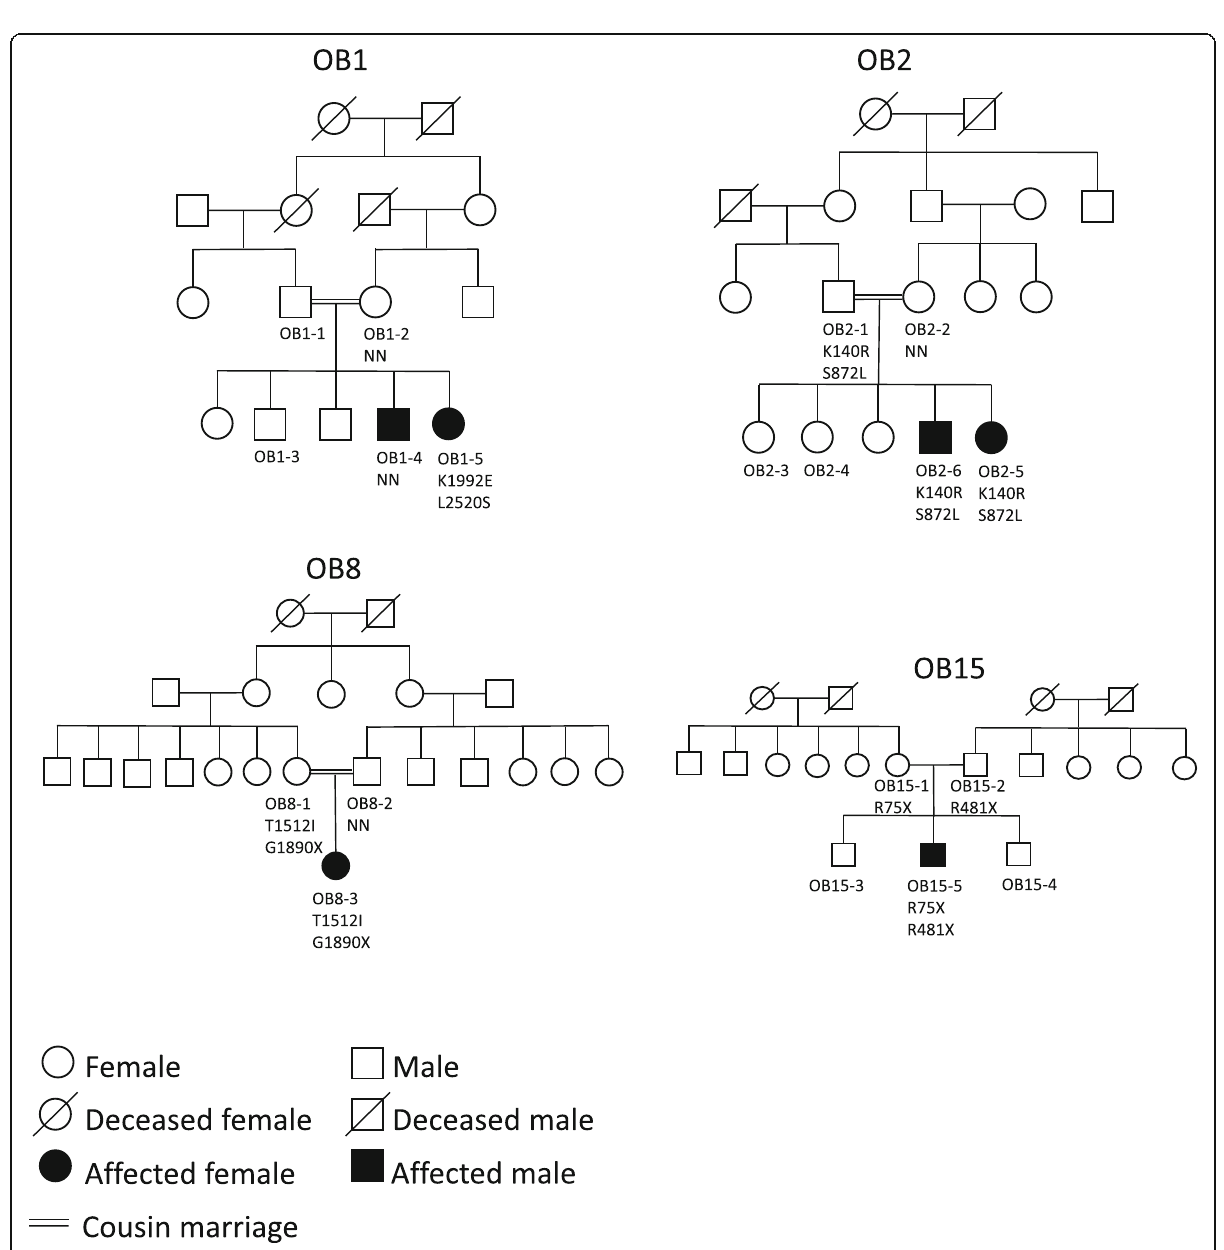
Fig. 1 Pedigrees of families in which probands carry two mutations within the same gene. Possibly causal variant are denoted under the carrier